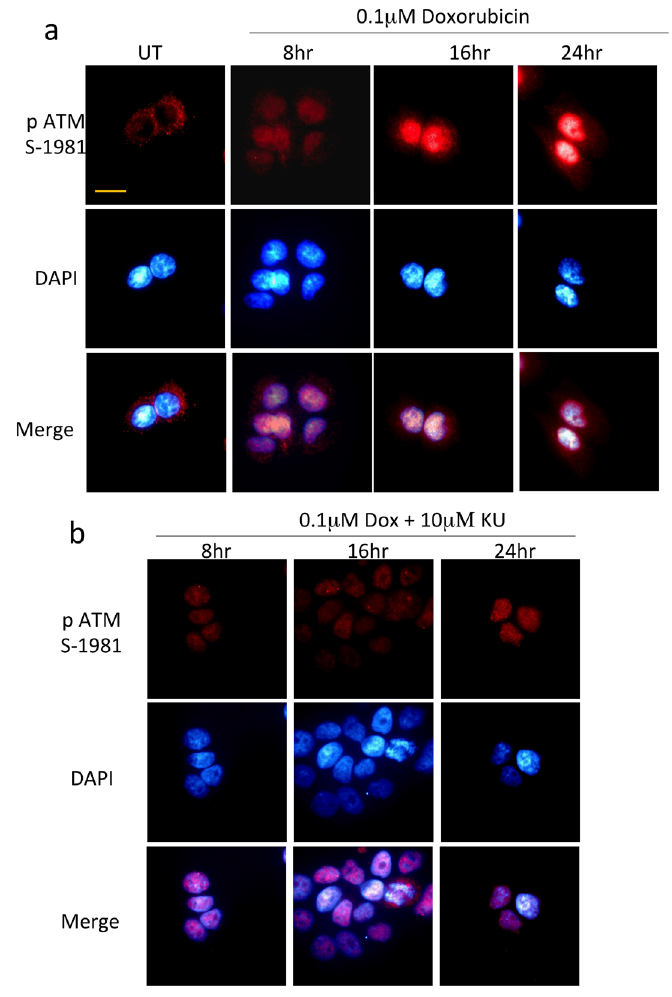
Figure 5. Double stranded DNA damage induces time dependent nuclear induction of pATM Serine 1981 exhibiting an active DDR pathway. Immunofluorescent labelling of endogenous ATM was performed by seeding 0.5x10 5 cells on to poly L lysine coated coverslips placed in 12-well tissue plates for 18 h. Following this, cells were either left untreated or treated with 100nM Dox alone (a) or with 100nM Dox and 10μM KU (b) for the indicated time points and further processed for immunocytochemistry as described in materials and methods. To stain endogenous pATM, cells were incubated with anti pATM Serine 1981 primary antibody (see antibody table) followed by using Alexa Fluor®568 (red fluorescence) conjugated secondary antibody (Invitrogen). To show nuclear co-localisation, cells were stained with 4’, 6-Diamidino-2-phenylindole, Dihydrochloride (DAPI). These are representative images captured in different field of views under 100x objective with relevant filters sets using Leica DMiRe2 electronic microscope. Scale bar represents